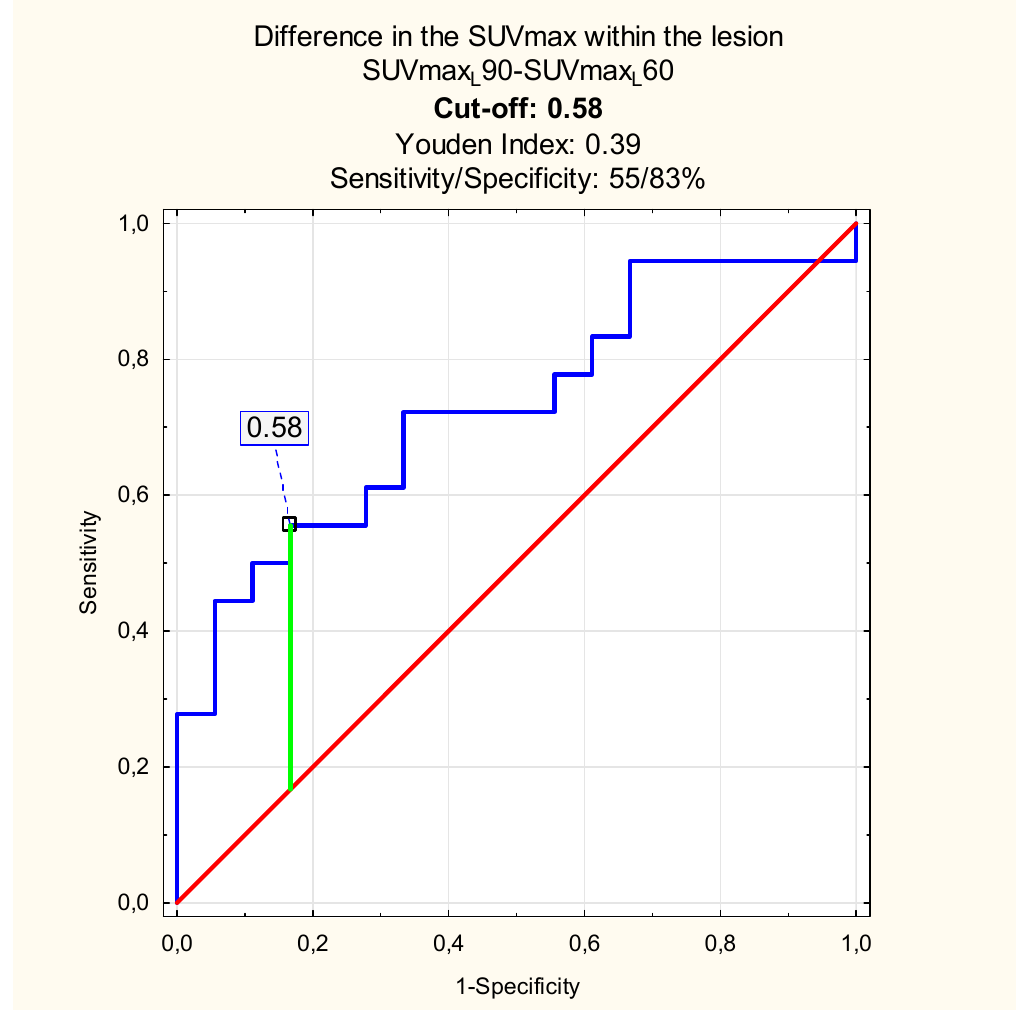
Figure 4. SUVmax max value cut-off: SUVmax within the lesion at 90 vs. 60 min p.i. (blue line—sensitivity, red line—specificity, green—cut-off point).